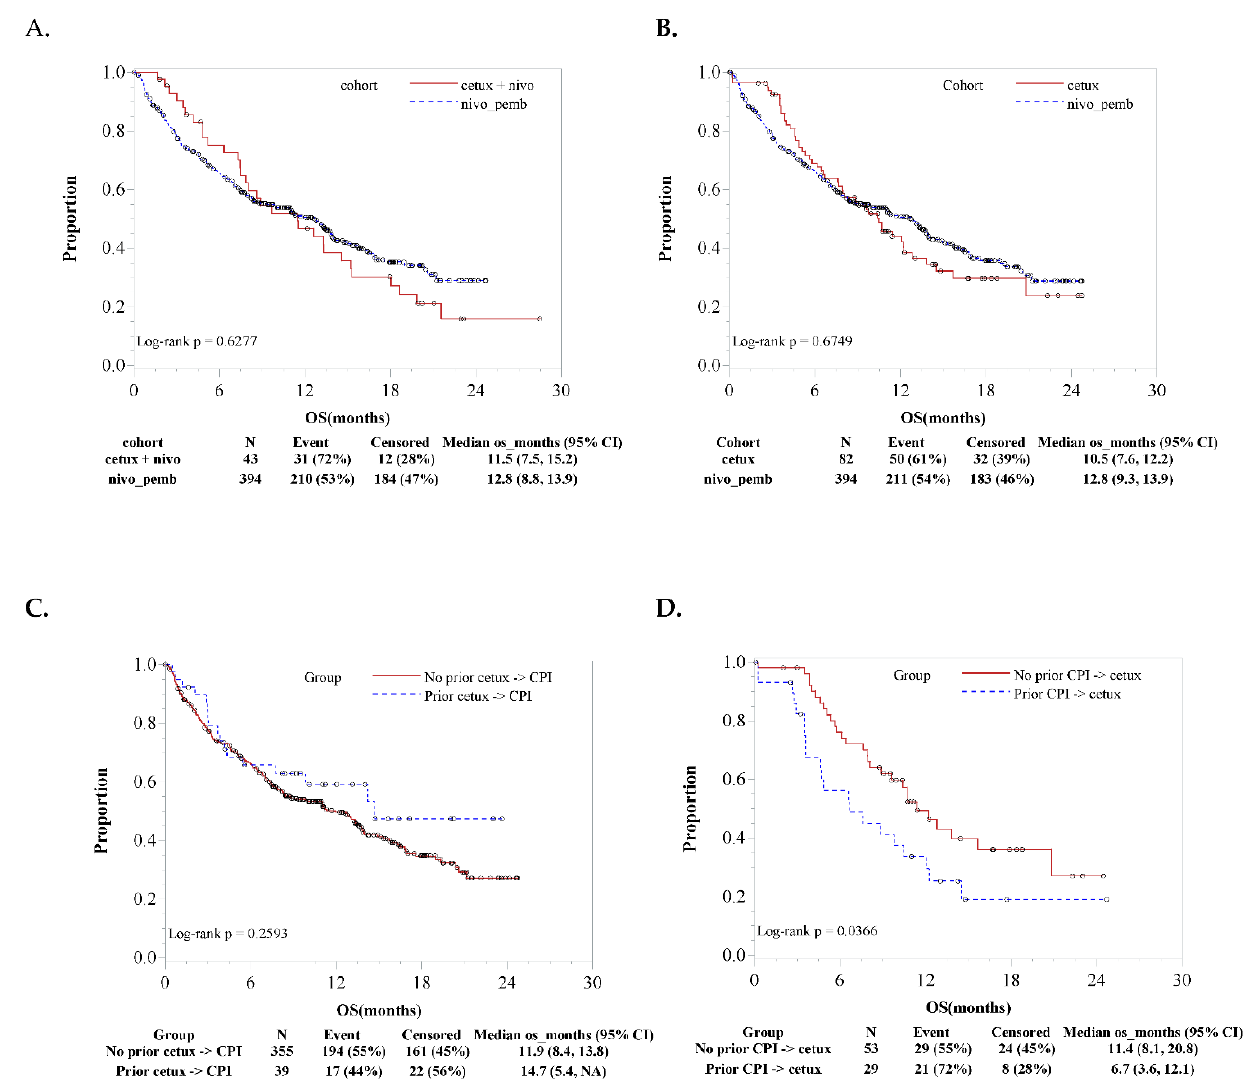
Figure 3. ( A ) Overall survival (OS) comparison between the combination of cetuximab and nivolumab in the clinical trial cohort and nivolumab or pembrolizumab checkpoint inhibitor (CPI) monotherapy in the real-world data (RWD-CPI) cohort. ( B ) OS comparison between the RWD-cetuximab cohort and RWD-CPI cohort. ( C ) OS comparison between the patients who received RWD-cetuximab and the patients who did not receive RWD-cetuximab before receiving RWD-CPI. ( D ) OS comparison between the patients who received RWD-CPI and the patients who did not receive RWD-CPI before receiving RWD-cetuximab. All analyses were conducted after adjusting the clinical characteristics of the cohorts using propensity score matching.